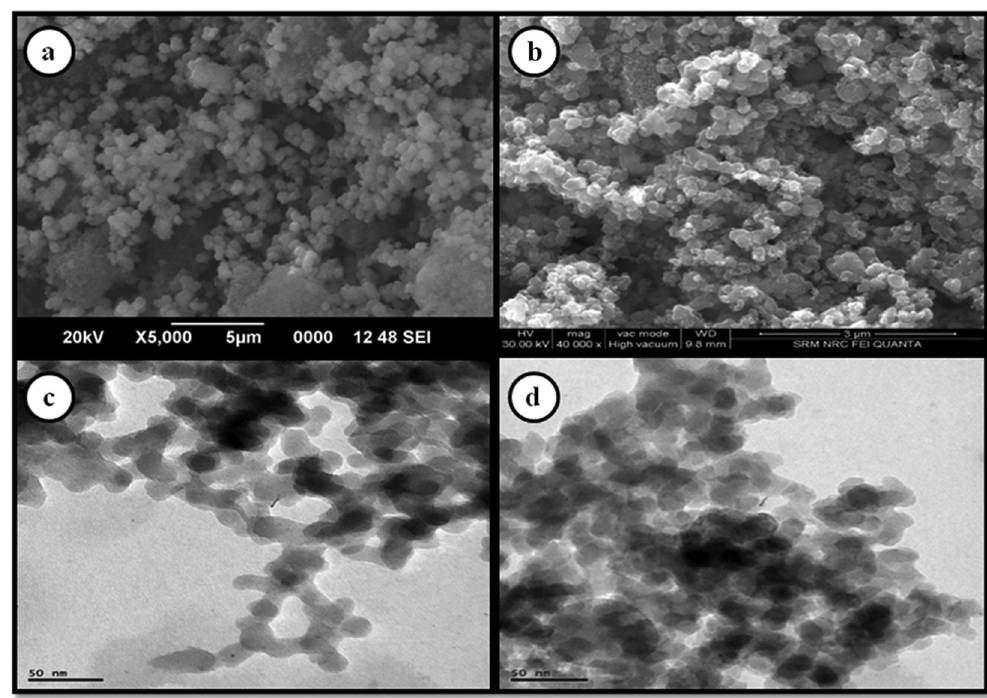
Figure 3: SEM analysis of ( a ) TiO 2 and ( b ) Ce - doped TiO 2 . TEM and SAED analysis of ( c ) TiO 2 and ( d ) Ce - doped TiO 2 .